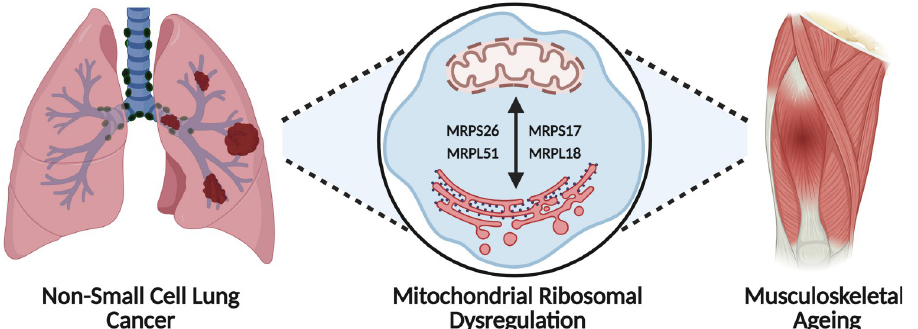
Fig 5. Dysregulated expression of mitochondrial ribosomal protein genes, Mitochondrial Ribosomal Protein S26 (MRPS26), Mitochondrial Ribosomal Protein S17 (MRPS17), Mitochondrial Ribosomal Protein L18 (MRPL18) and Mitochondrial Ribosomal Protein L51 (MRPL51), as marker of musculoskeletal ageing and non-small cell lung cancer disease progression.